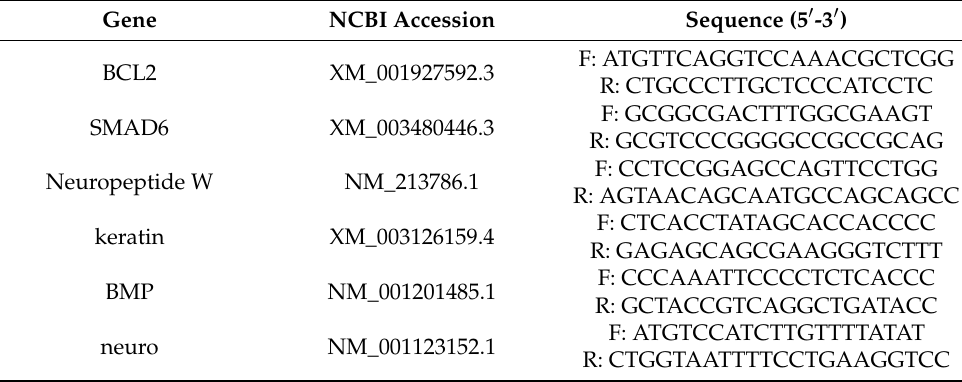
Table 1. Primer sequence for